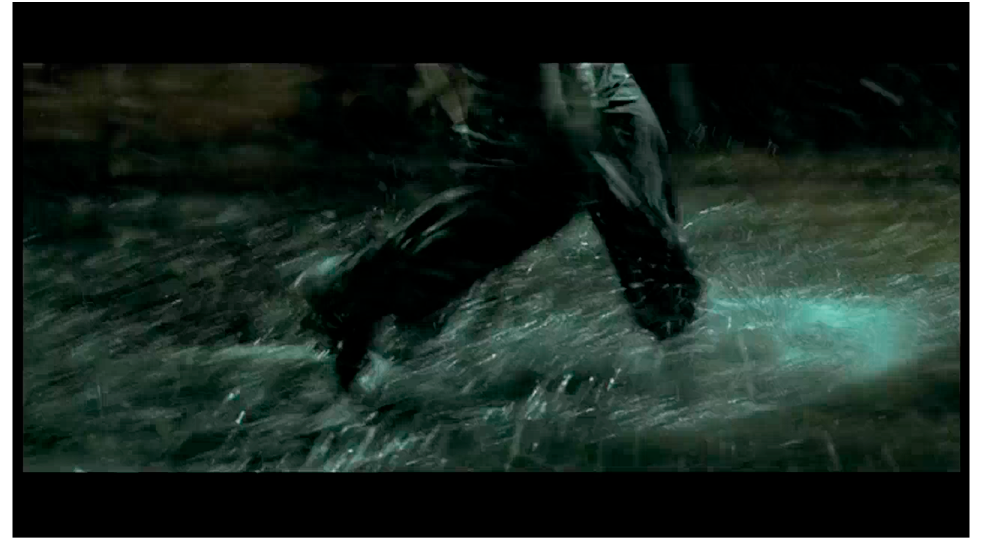
Figure 19. A seething tangle of movement that mimics an Abstract Expressionist painting. Frame capture, The Grandmaster (Wong 2013).